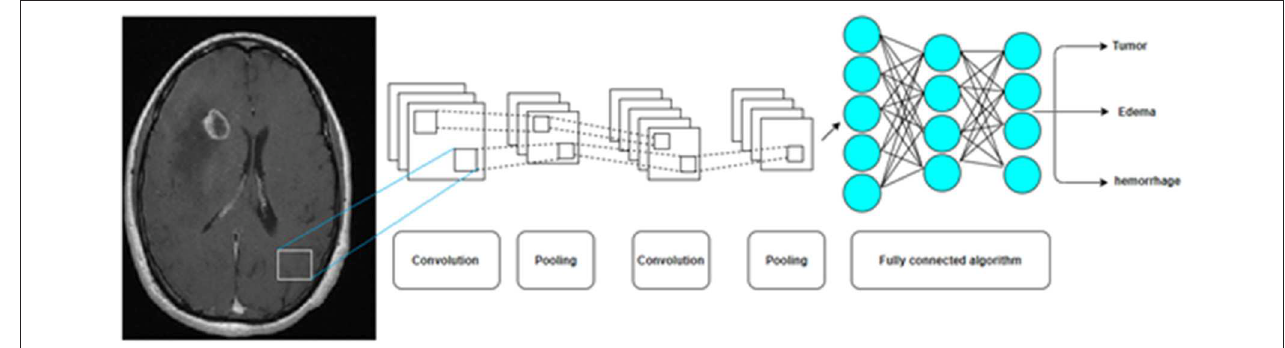
FIGURE 6 | A Convolution Neural Network (CNN) by multiple pooling and convolution steps before a deep neural network is now the most common AI algorithm for image